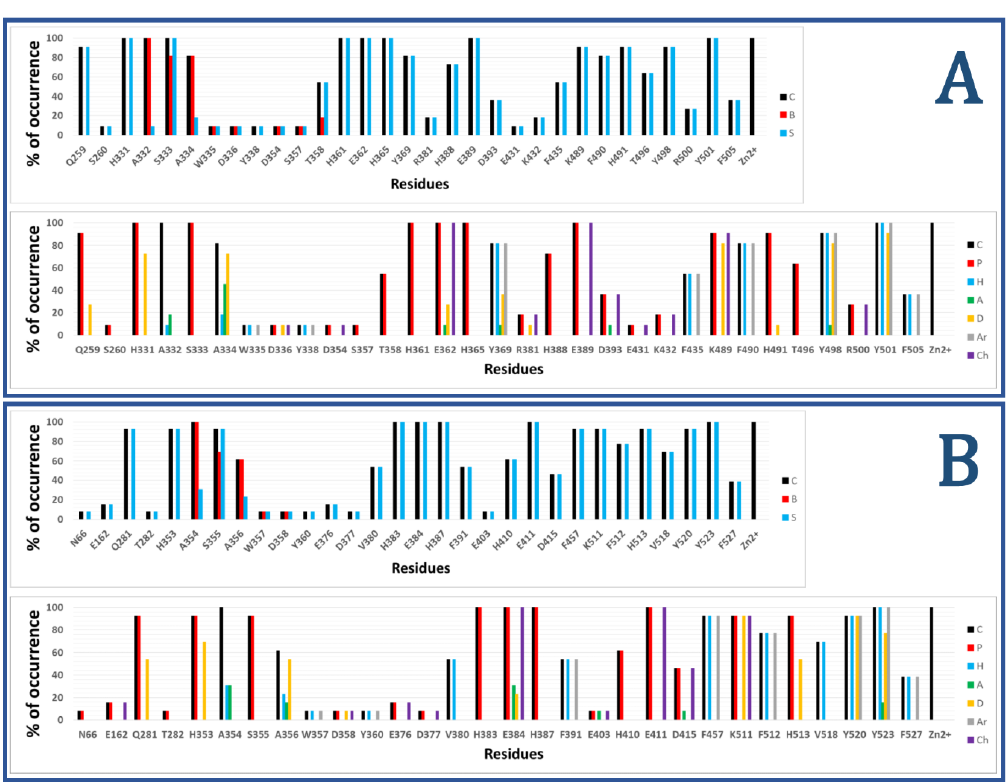
Figure 2. Occurrence of interaction types at the nACE and cACE binding interfaces from IFPs for ACE-ligand structures reported in PDB, (nACE-ligand structures are in ( A ) and cACE-ligand structures are in ( B )). Top part of both A and B plots % of occurrence of contacts C, interactions with the backbone of the residue B, and interactions with the side chain of the residue S per residue. Bottom part of both A and B plots % of occurrence of chemical interactions: contacts C, polar P, hydrophobic H, HBs where the residue is acceptor A, HBs where the residue is donor D, aromatic Ar, and electrostatic with charged groups